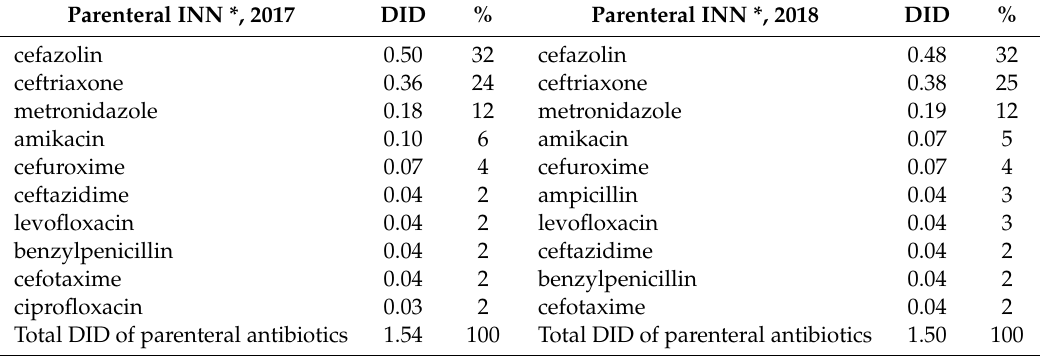
Table 2. Comparative analysis of the consumption of the top 10 parenteral antibiotics for the period